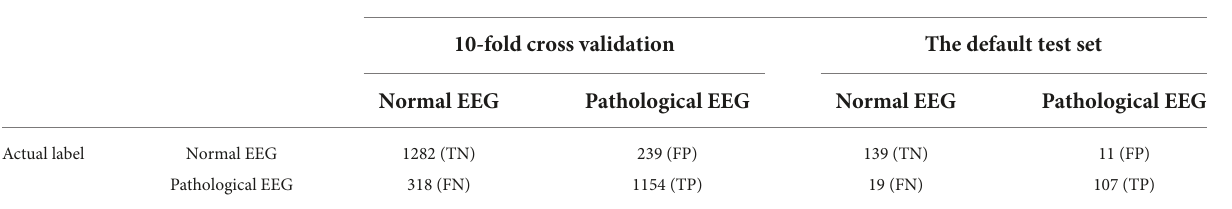
TABLE 3 Confusion matrix for the proposed CatBoost-based method.